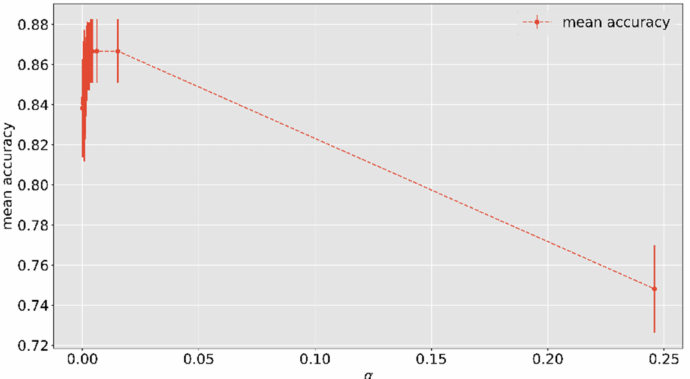
Figure 5. Average accuracy through